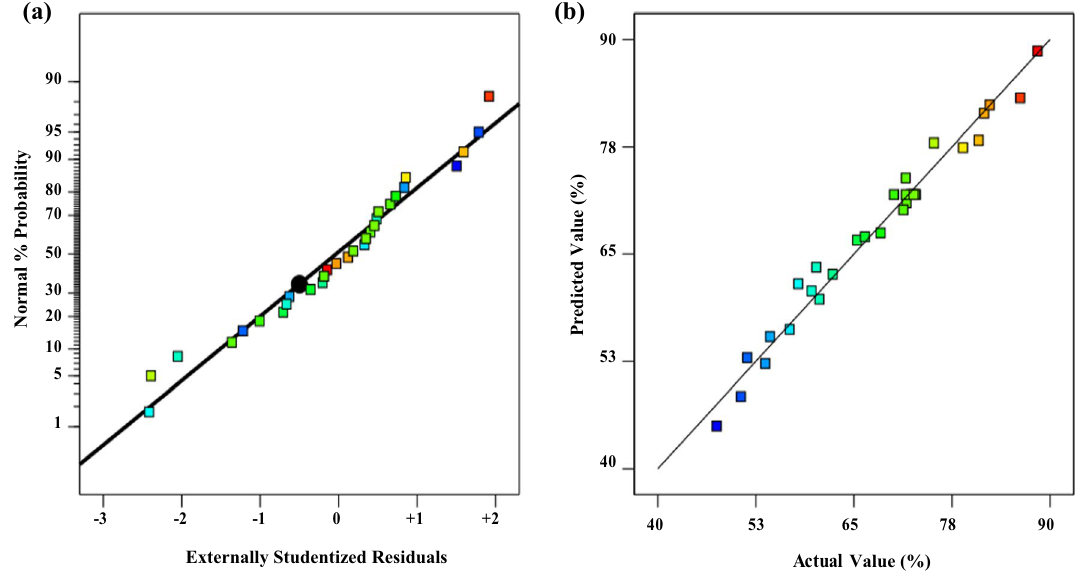
Fig. 2 Residual diagnostics of developed HDZ removal model: a normal probability plot vs. externally studentized residuals, b predicted vs. actual